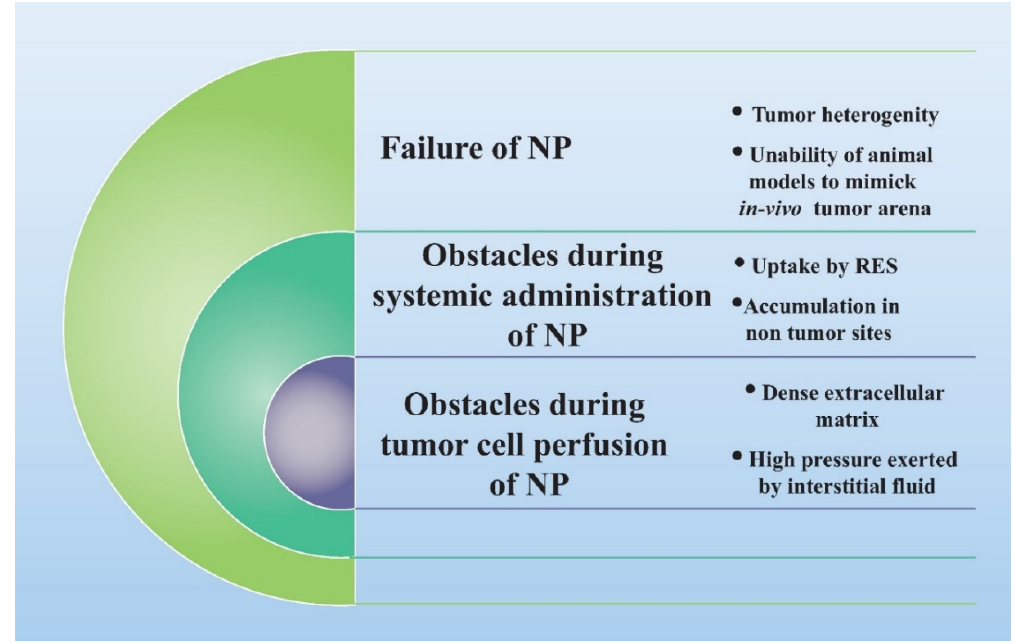
Figure 1. Barriers to efficacious in vivo performance of nanomedicines.